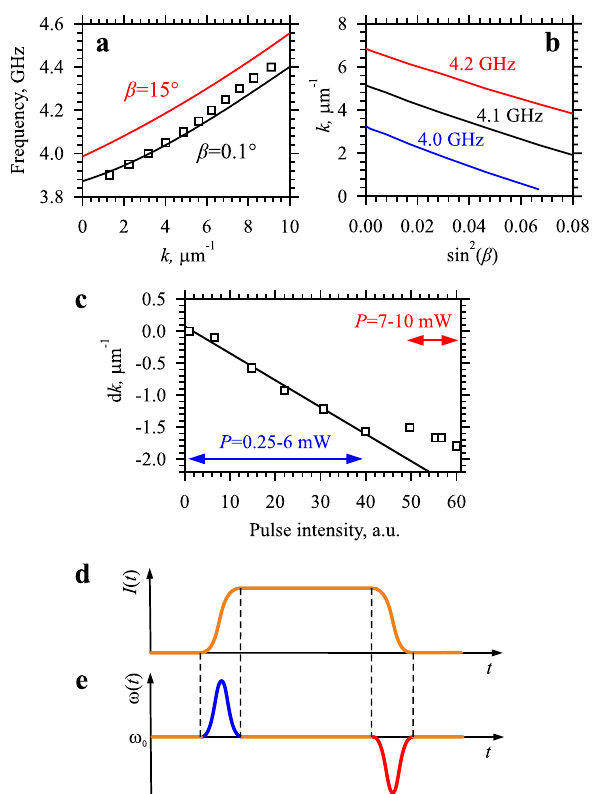
Figure 4. Characterization of the nonlinear spectral shift. ( a ) Curves show the frequency vs wavenumber dependences for spin waves in the studied waveguide obtained from micromagnetic simulations for two different precession angles β , as labelled. Squares frequency versus wavenumber dependence measured at P = 0.25 mW in the continuous-wave excitation regime. ( b ) Dependences of the wavenumber on sin obtained from micromagnetic simulations for different frequencies, as labelled. ( c ) Squares nonlinear reduction of the wavevector d k = k C ( P ) -k 0 corresponding to the initial stage of the pulse propagation as a function of the intensity of the spin-wave pulse detected by BLS. Line linear fit for P = 0.25–6 mW. ( d–e ) Schematic illustration of the SPM process. ( d ) Temporal dependence of the wave intensity. ( e ) The resulting modulation of the instantaneous